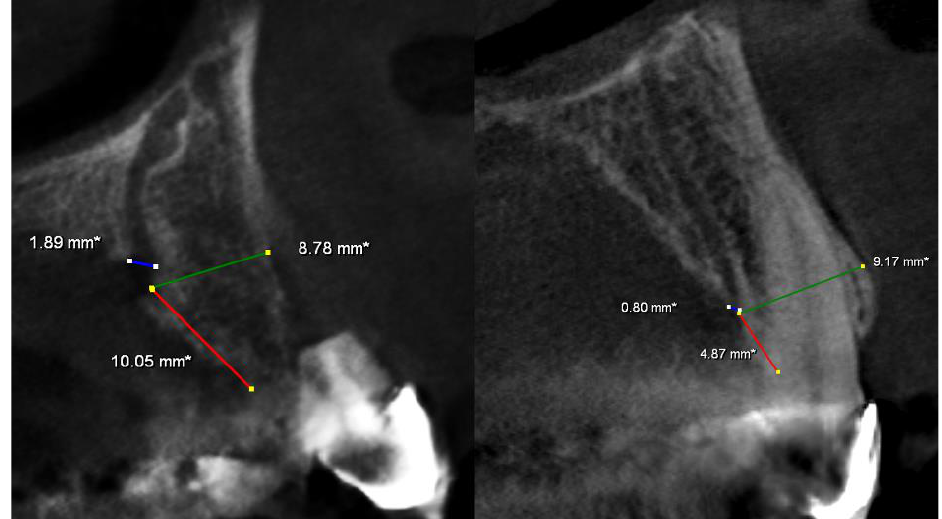
Figure 3. Radiological examination pattern of the AC diameter ( blue line ), AC distance to the buccal cortical plate ( green line ), and AC distance to the crest of the alveolar ridge ( red line ).